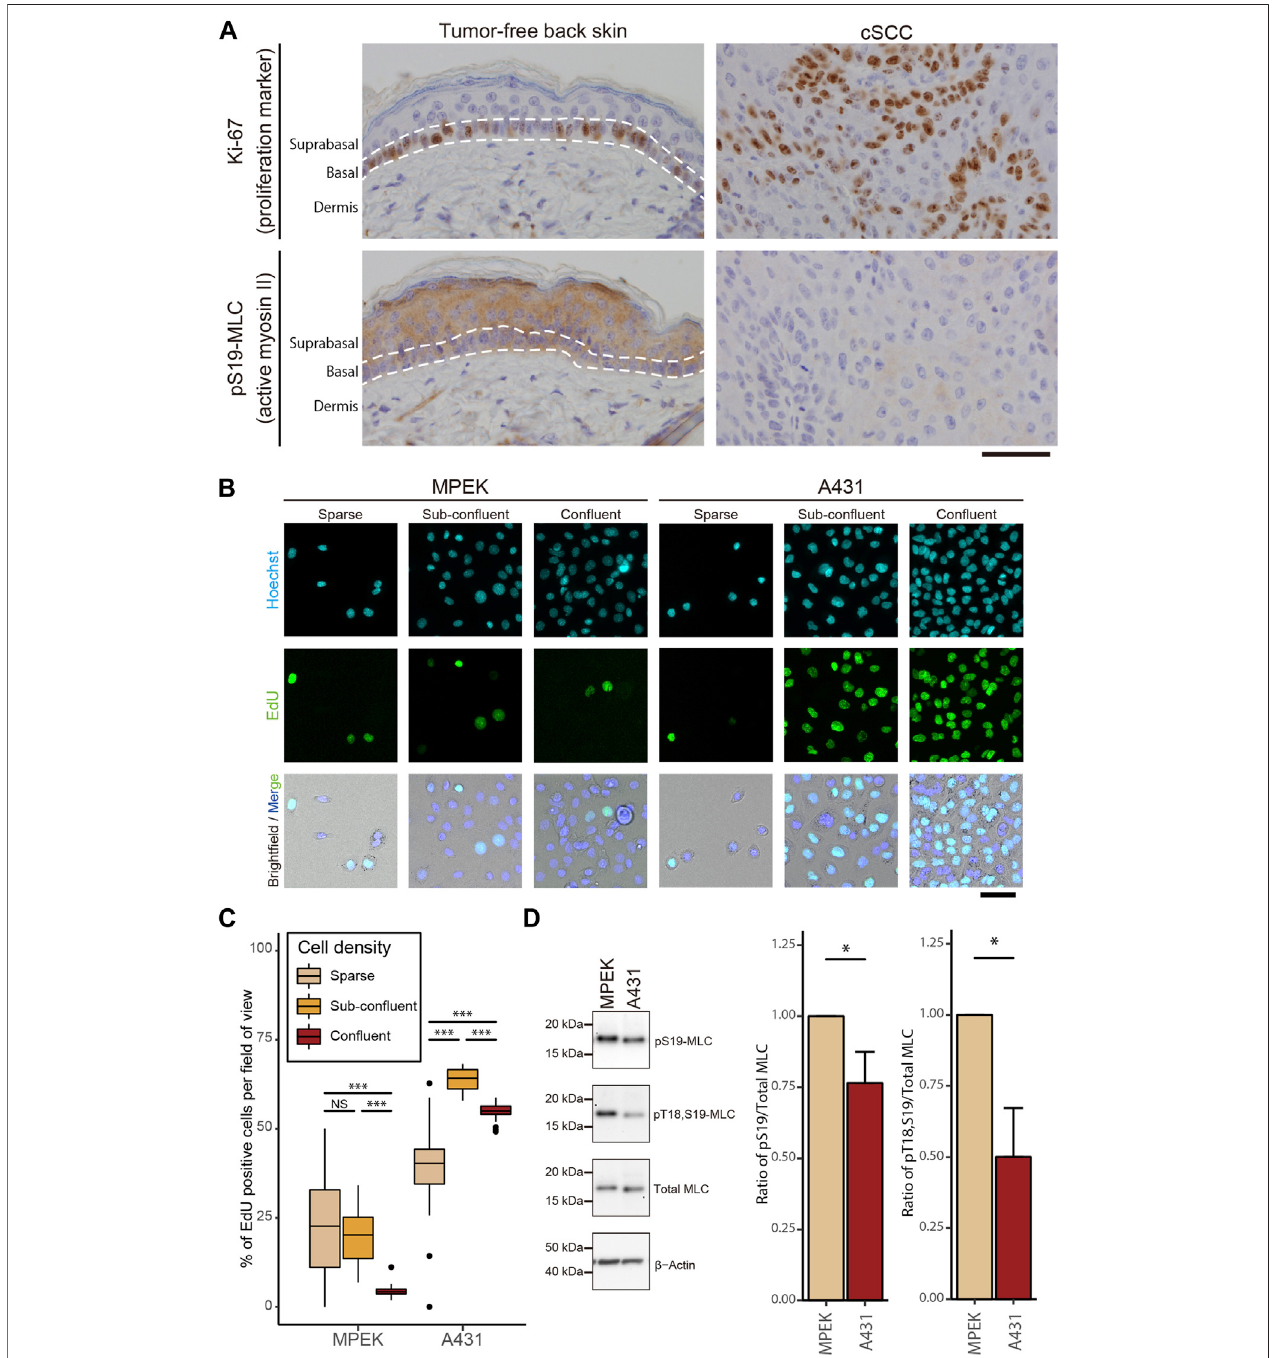
FIGURE 1 | Impairment of actomyosin contractility is associated with hyperproliferation of cSCC cells both in vitro and in vivo . (A) DMBA/TPA-treated tumor-free mouse back skin and cSCC were subjected to IHC staining for Ki-67 and pS19-MLC. Scale bar, 50 μ m. (B) Fluorescence microscopy analysis of EdU incorporation (green) in MPEK and A431 cells under sparse, sub-con fl uent, and con fl uent conditions. Under the sparse condition, only sequestered cells lacking any cell-cell contact were used for the analyses. Cell nuclei were labeled with Hoechst 33342 (cyan). Scale bar, 50 μ m. (C) Percentages ofEdU-positive nuclei in MPEK and A431 cells at different cell densities. Box-and-whisker plots show the median, the interquartile range, and the tenth and ninetieth percentiles. n (cid:1) 40 fi elds of view from two independent experiments ( > 1500 cells per condition) were pooled for the analysis. *** p < 0.001; NS, p > 0.05. (D) Whole-cell lysates of con fl uent MPEK and A431 cells were immunoblotted for pS19-MLC, Thr18-and Ser19-doublephosphorylated MLC (pT18,S19-MLC), total MLC, and β -actin. Bar graphs show the quanti fi cation of the densitometric ratio of pS19-MLC or pT18,S19-MLC against total MLC. Values were normalized with the mean values in MPEK cells. Each bar represents mean ± SD from three independent experiments. * p <